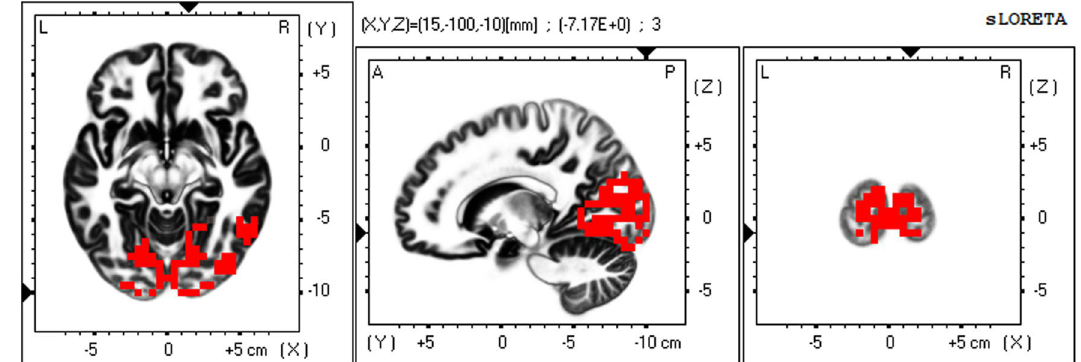
Figure 1. Occipital alpha activity. The occipital alpha activity is composed of alpha activity in the occipital cortex. In the colour–coded maps, red colour represents power increase with increasing network activity. Slices from left to right are axial, sagittal and coronal images (viewed from top, left and back). L, left; R, right; A, anterior; P, posterior.